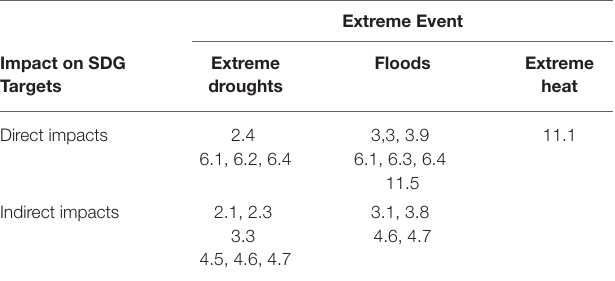
TABLE 1 | Extreme events and impacts on specific SDG